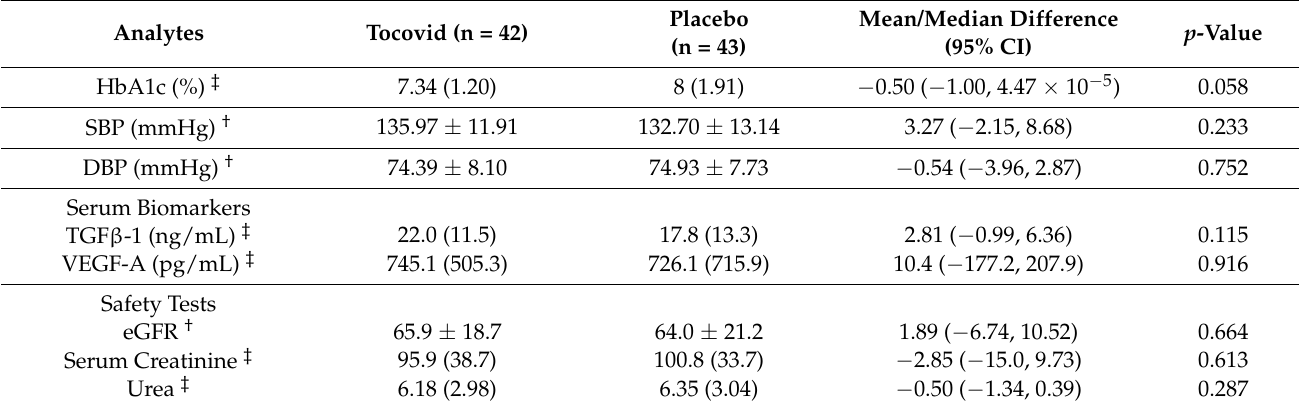
Table 5. Comparison of analytes between intervention and placebo groups at the end of